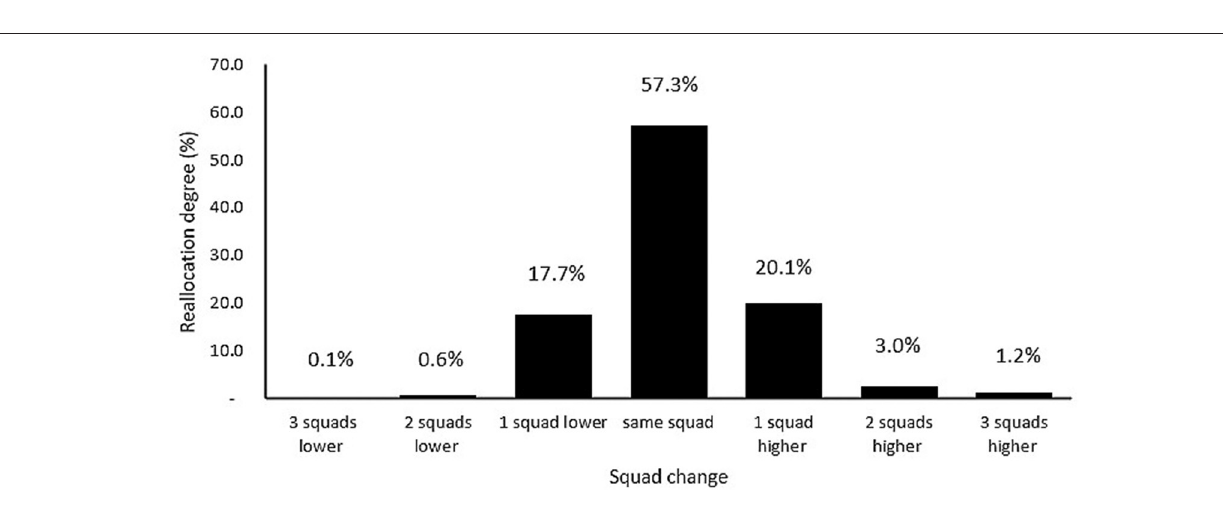
FIGURE 5 | Percentage of players (%) who will be reallocated to another age